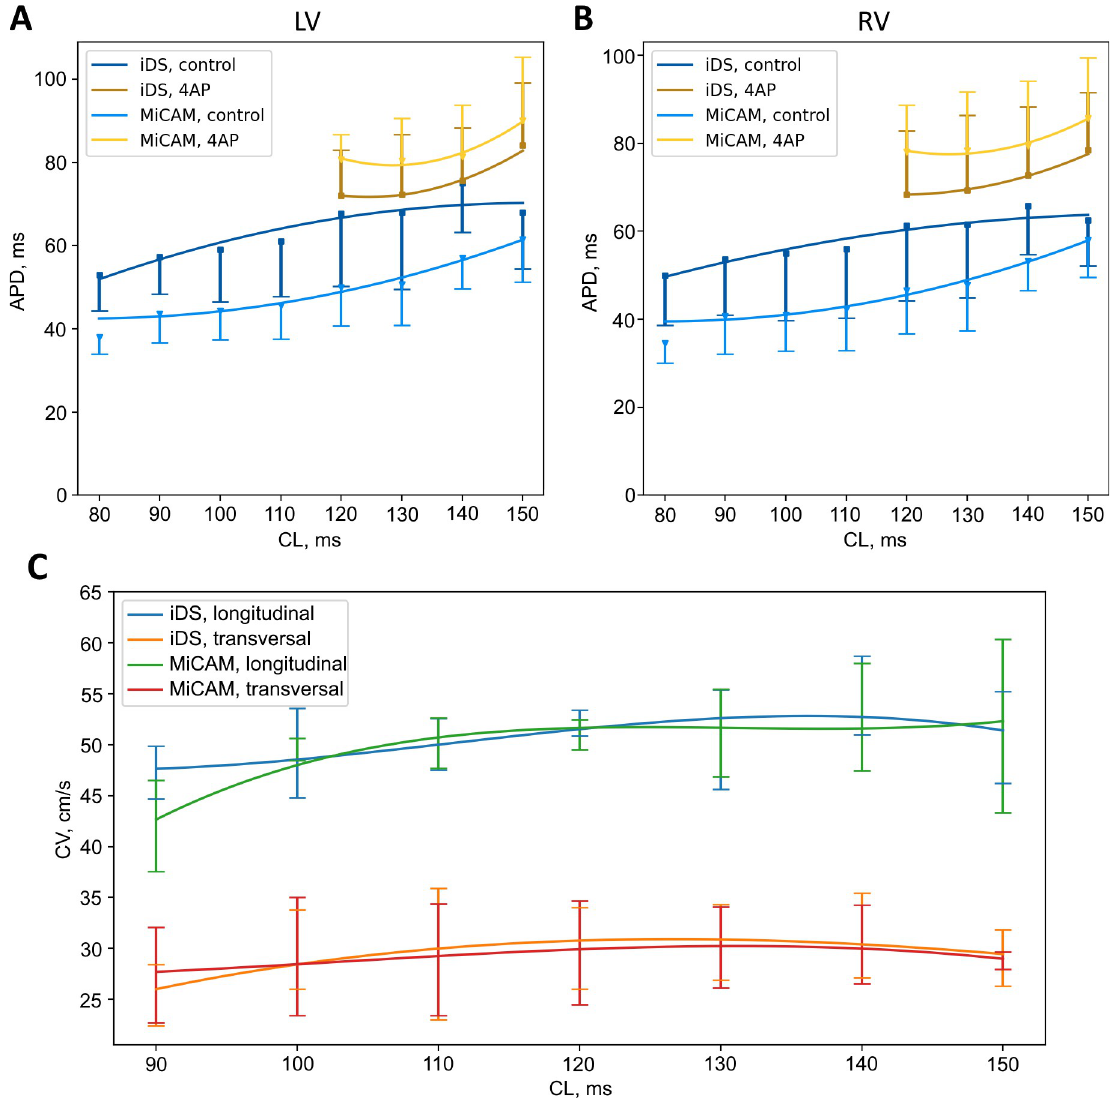
Fig 6. APD and CV restitution curves. (A,B) APD80 restitution in control and in presence of 5.6 mM 4AP in left ventricle. (C) Longitudinal/transversal CV restitution measured by iDS and MiCAM